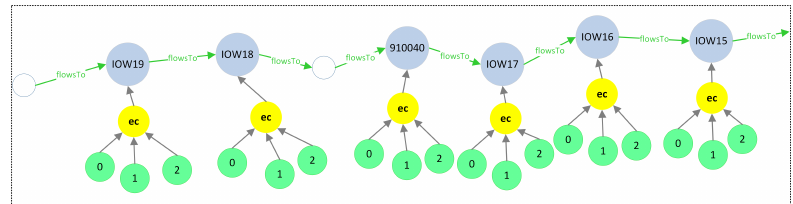
Figure 18. Neo4j Graph using the categorization based on local